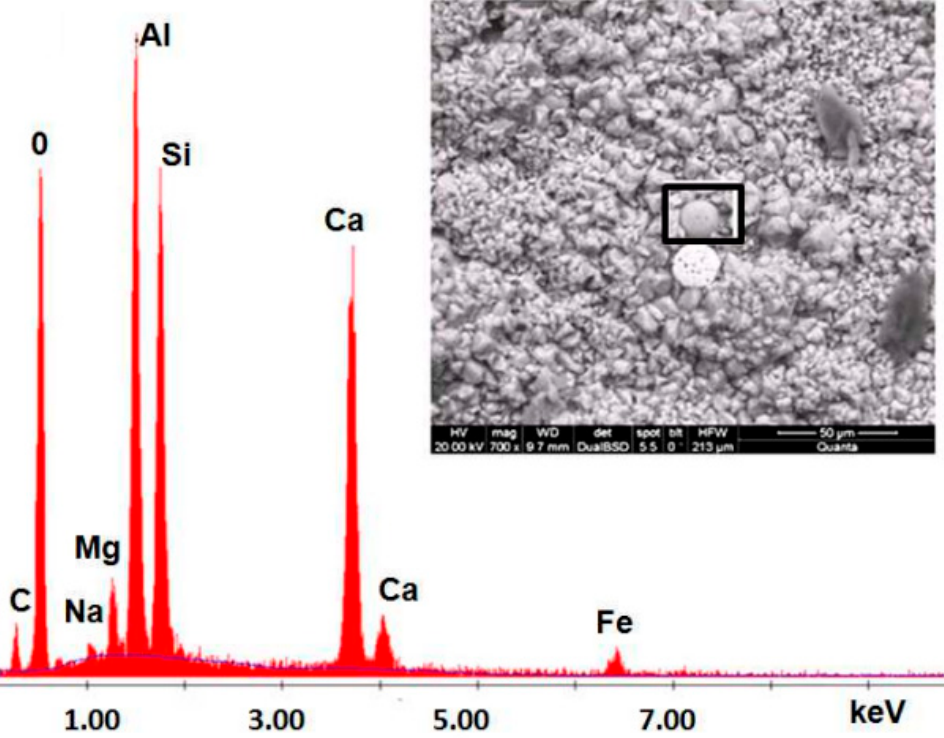
Figure 20. SEM and EDX curve showing the chemical composition of geopolymer concrete [99].